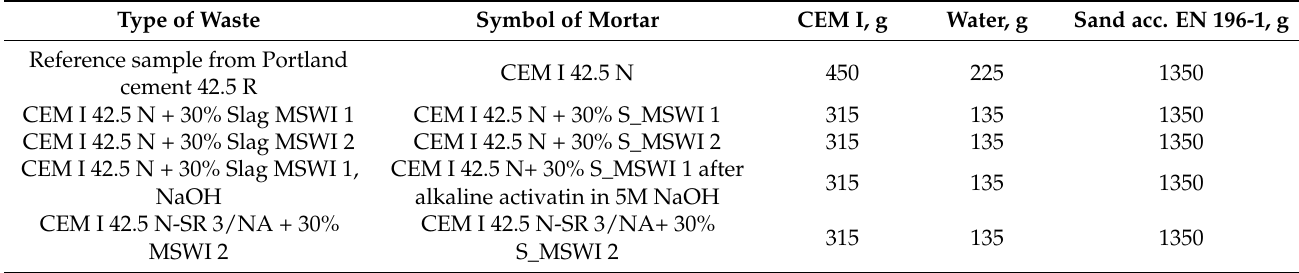
Table 1. Composition concrete mortars.